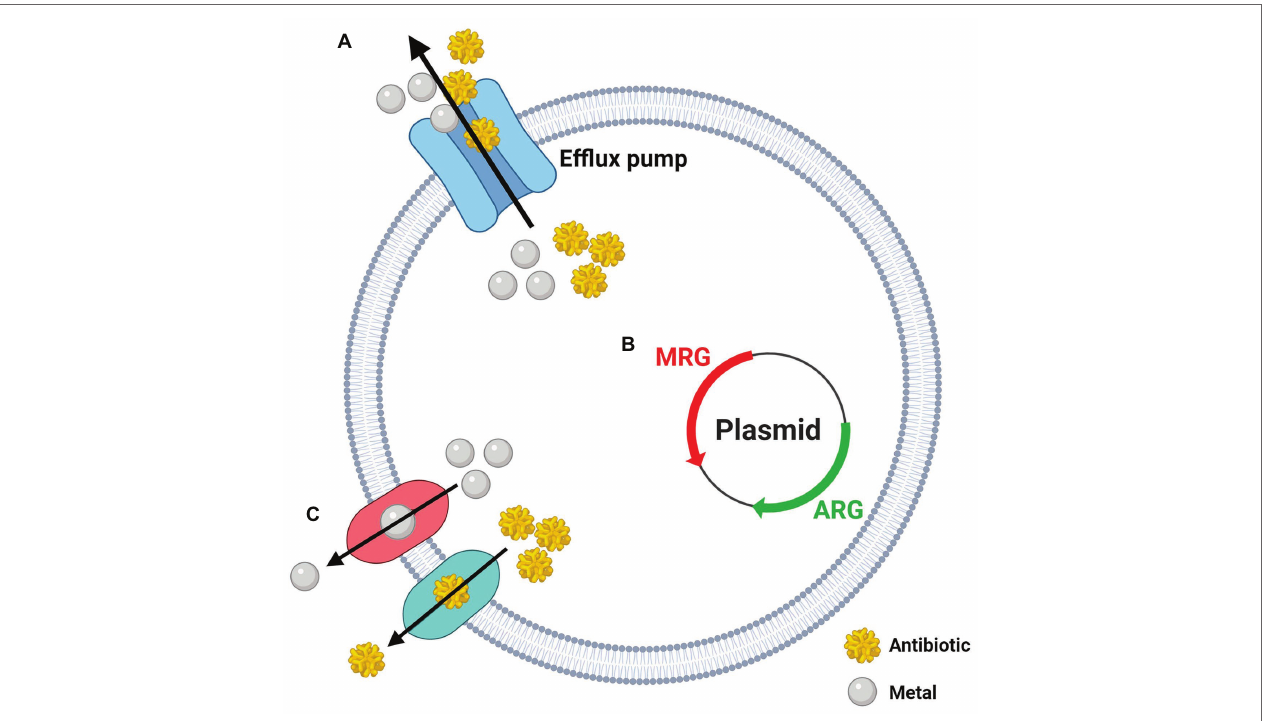
FIGURE 4 | The three potential mechanisms behind the co-selection of heavy metal and antibiotic resistance. (A) Cross-resistance: one gene/mechanism confers resistance to metals and antibiotics at once (i.e., efflux pumps); (B) Co-resistance: genes coding for metal resistance (MRG) and antibiotic resistance (ARG) are grouped together on the same genetic element (i.e., plasmids); (C) Co-regulation: expression of individual metal and antibiotic resistance systems are managed by a common gene or regulator. Created in BioRender. Adapted from Pal et al. (2017; Lic. No.